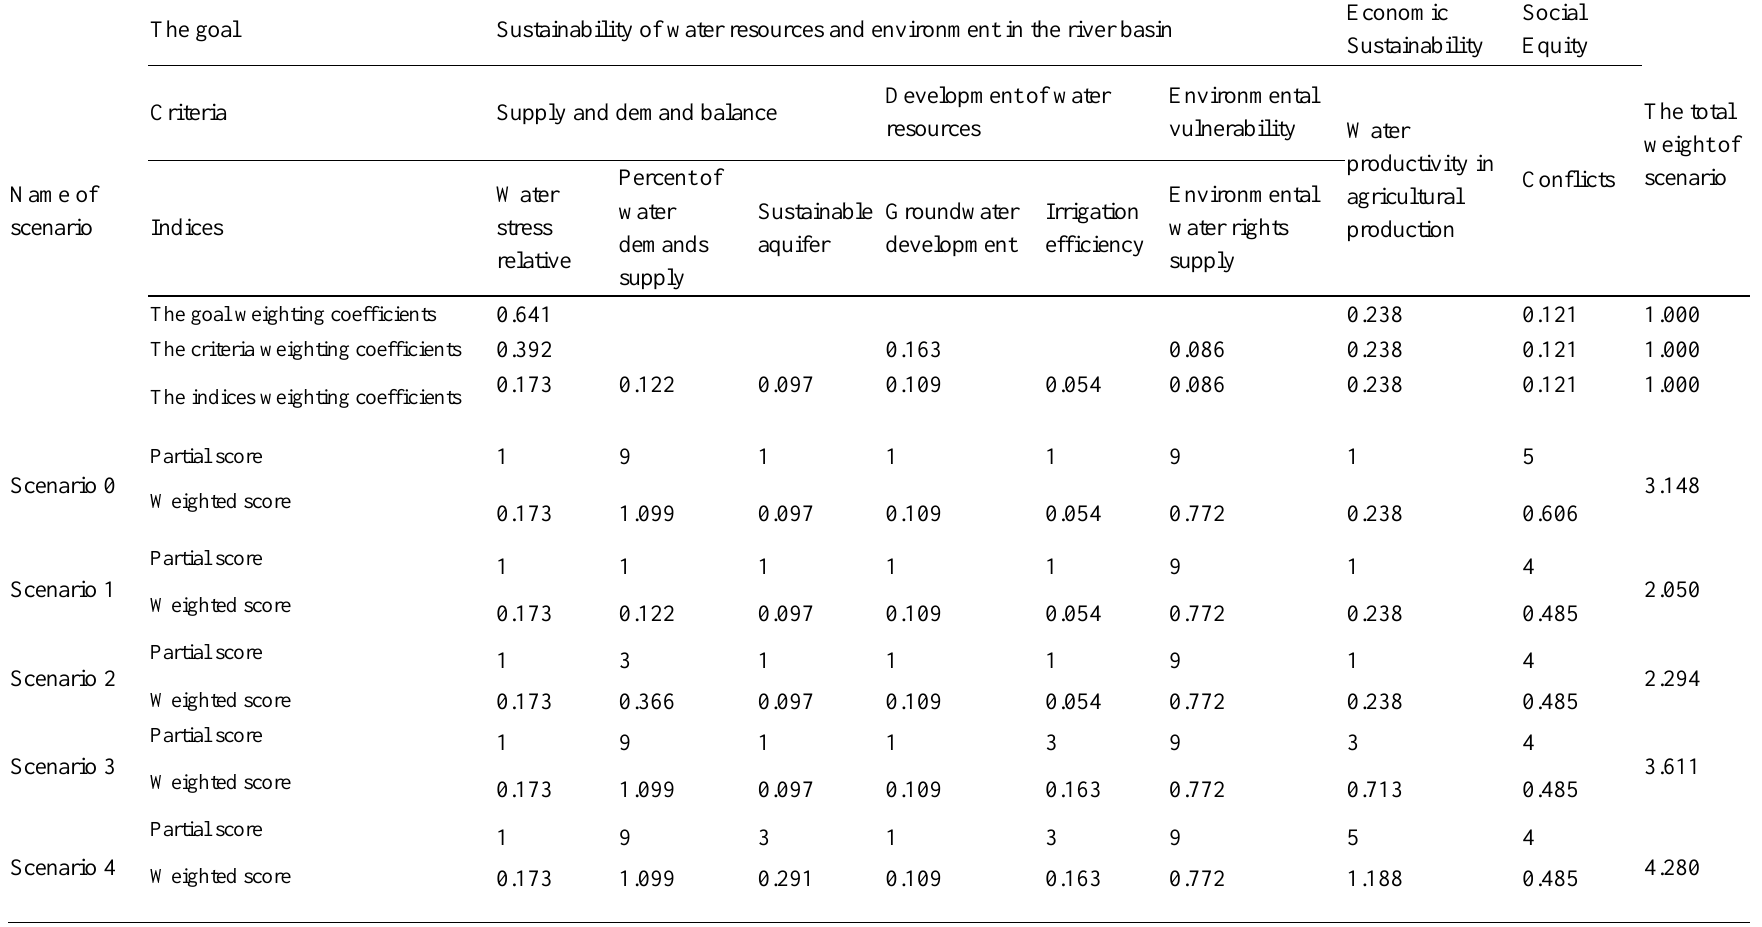
Table 4. The results of ranking different